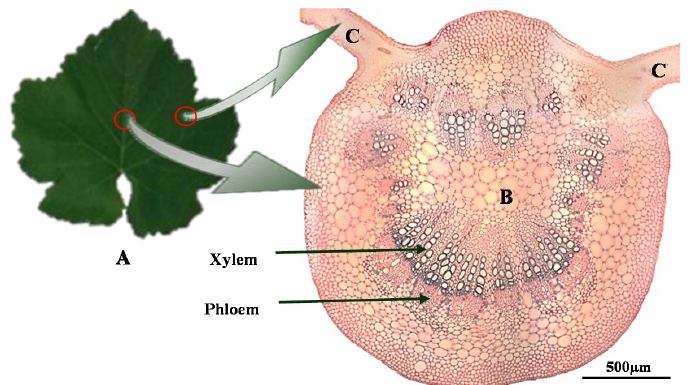
Figure 4. Vitis vinifera leaf ( A ); main vein ( B ); mesophyll ( C ).